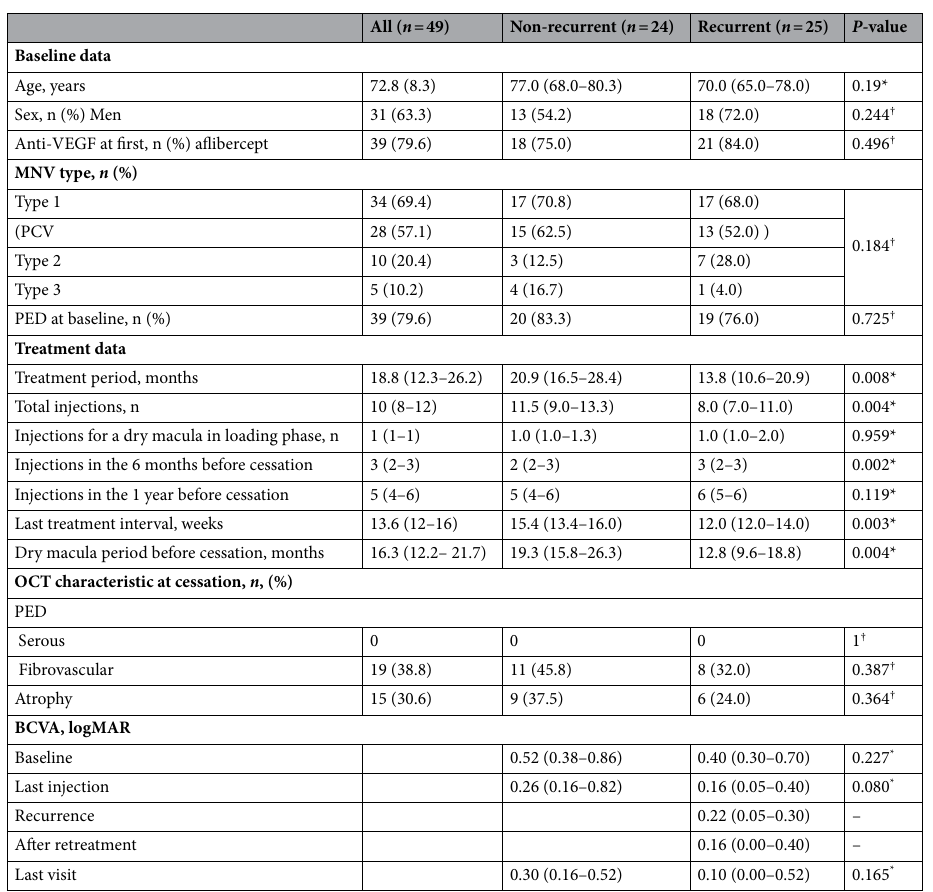
Table 1. Characteristics of patients with neovascular age-related macular degeneration with and without recurrence after cessation of treatment. Data are presented as median (Interquartile range), unless otherwise indicated. BCVA, best-corrected visual acuity; IRF, intraretinal fluid; logMAR, logarithm of the minimum angle of resolution; MNV, macular neovascularization; OCT, optical coherence tomography; PED, pigment epithelial detachment; SRF, subretinal fluid; VEGF, vascular endothelial growth factor. *Mann–Whitney U test. †A chi-square